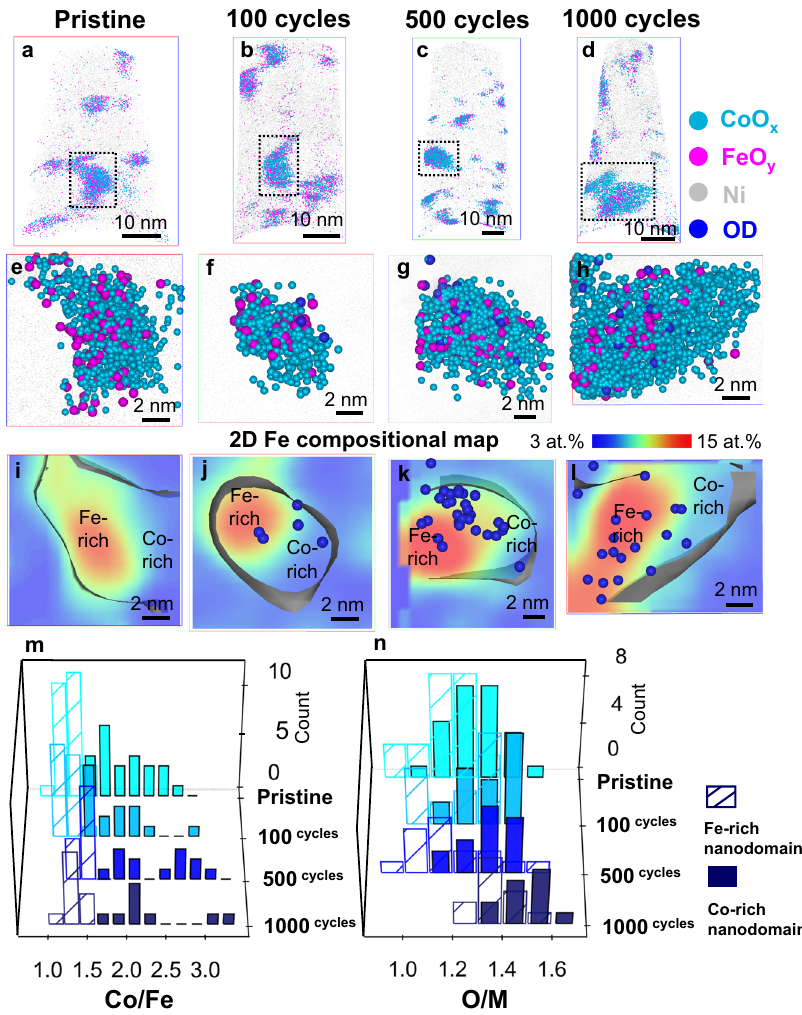
Fig. 4 Compositional evolution and elemental distribution of segregated Co 2 FeO 4 during OER. a – d 3D-APT reconstruction of Co 2 FeO 4 in the pristine state and after 100, 500 and 1000 cycles of CV showing the nanoparticles embedded in Ni matrix, e – h 3D atom maps of segregated Co 2 FeO 4 nanoparticles in the pristine state and after 100, 500 and 1000 cycles, selected from dashed line region in a – d ( f displayed in the top-down view of b ), and i – l 2D Fe compositional maps of the same nanoparticles in e – h showing the Co-rich and Fe-rich nanodomains, compositional histograms of m Co/Fe ratios and n O/M ratios (M = Co + Fe) in the Fe-rich and Co-rich regions of segregated Co 2 FeO 4 nanoparticles in a – d and Supplementary Fig. 12a – d. (Source data of Fig. 4m, n are provided as a Source Data fi